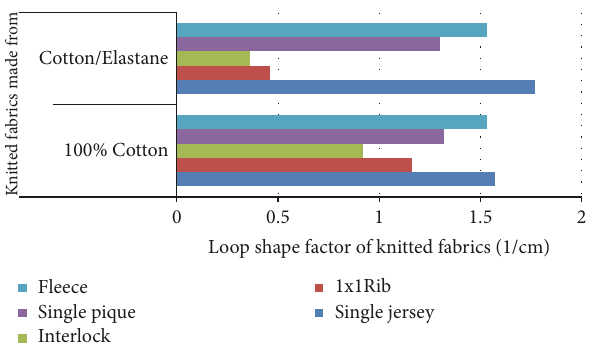
Figure 6: Loop shape factor of knitted fabrics made from 100% cotton and cotton/elastane yarns.